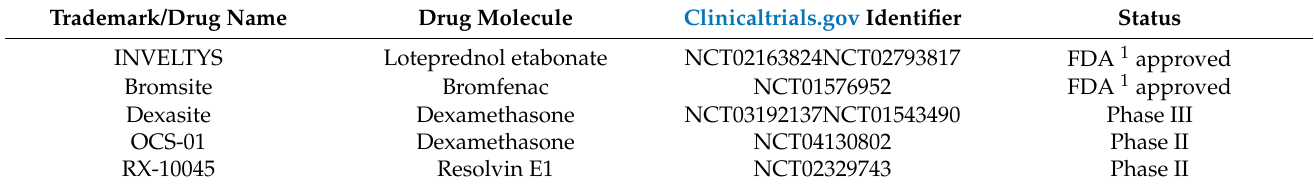
Figure 3. Schematic representation of ocular drug delivery systems for topical administration. Recently FDA approved and developed ocular drug systems presented. Created with BioRender.com. Table 2. Potential ocular drugs under clinical trial and approved by